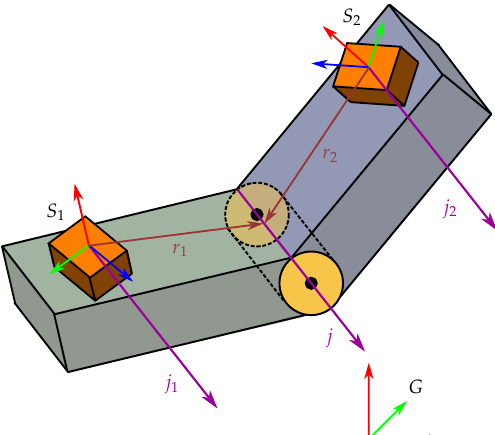
Figure 1. The hinge joint system that we consider. The two segments rotate independently with respect to each other only along the joint axis j . The sensor frames S i are rigidly fixed to their respective segments and their relative orientation can be described by one joint angle, that corresponds to a rotation about the joint axis. The joint axis expressed in local sensor coordinates is an important sensor-to-segment calibration parameter in joint systems with one degree of freedom